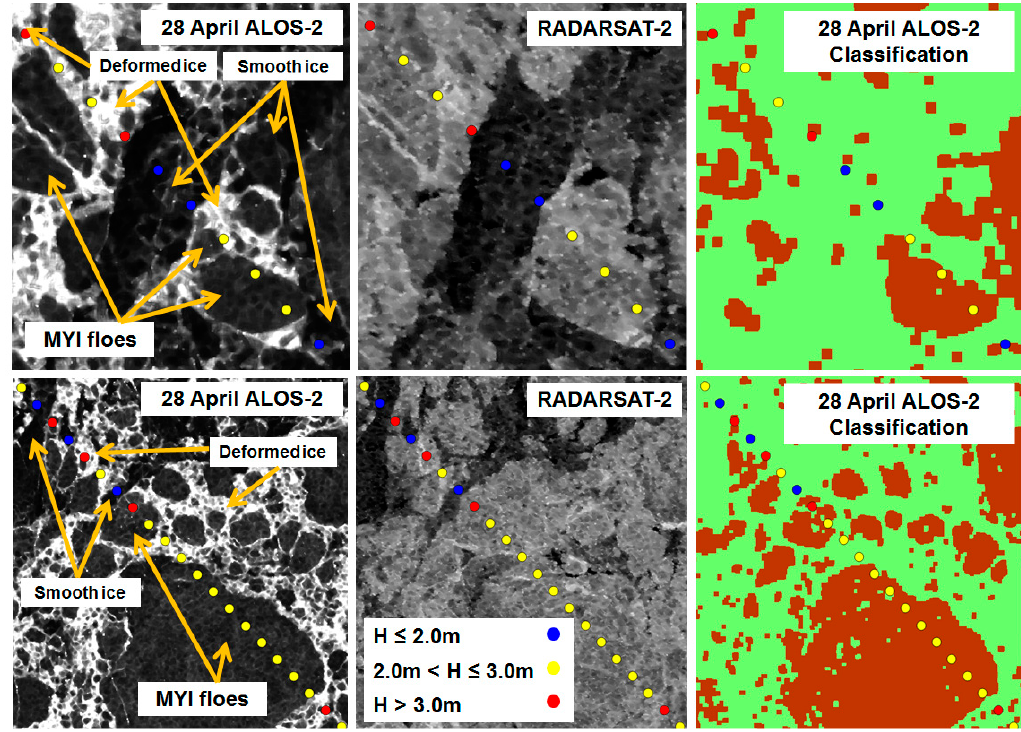
Figure 7. Ice thickness data overlaid on close-up samples of the 28 April ALOS-2 SPAN image, the RADARSAT-2 SPAN image, and the 28 April ALOS-2 image classification results.